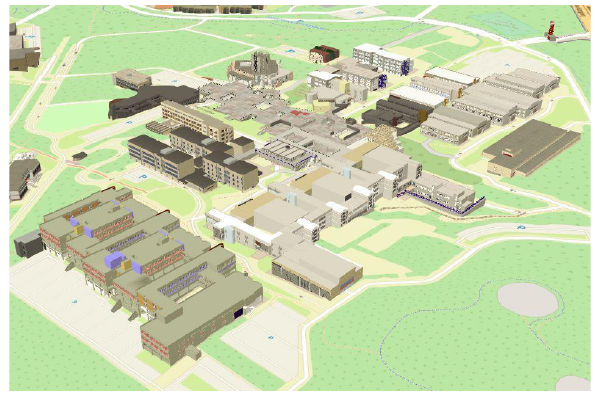
Figure 7. 3D NTUA Campus overview